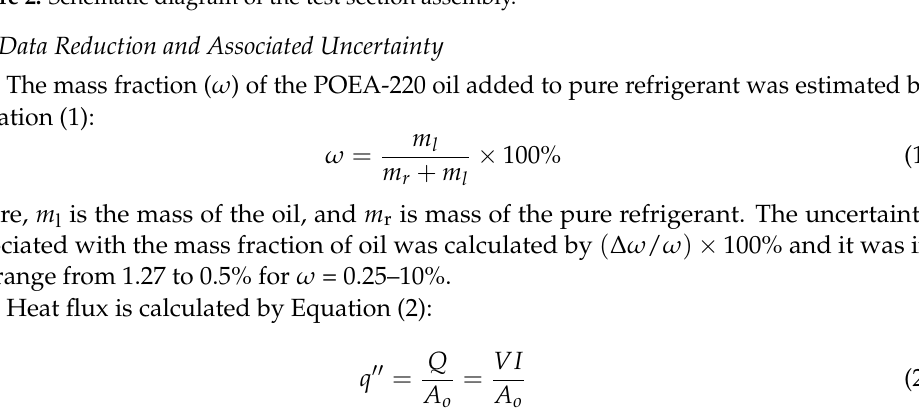
Figure 2. Schematic diagram of the test section